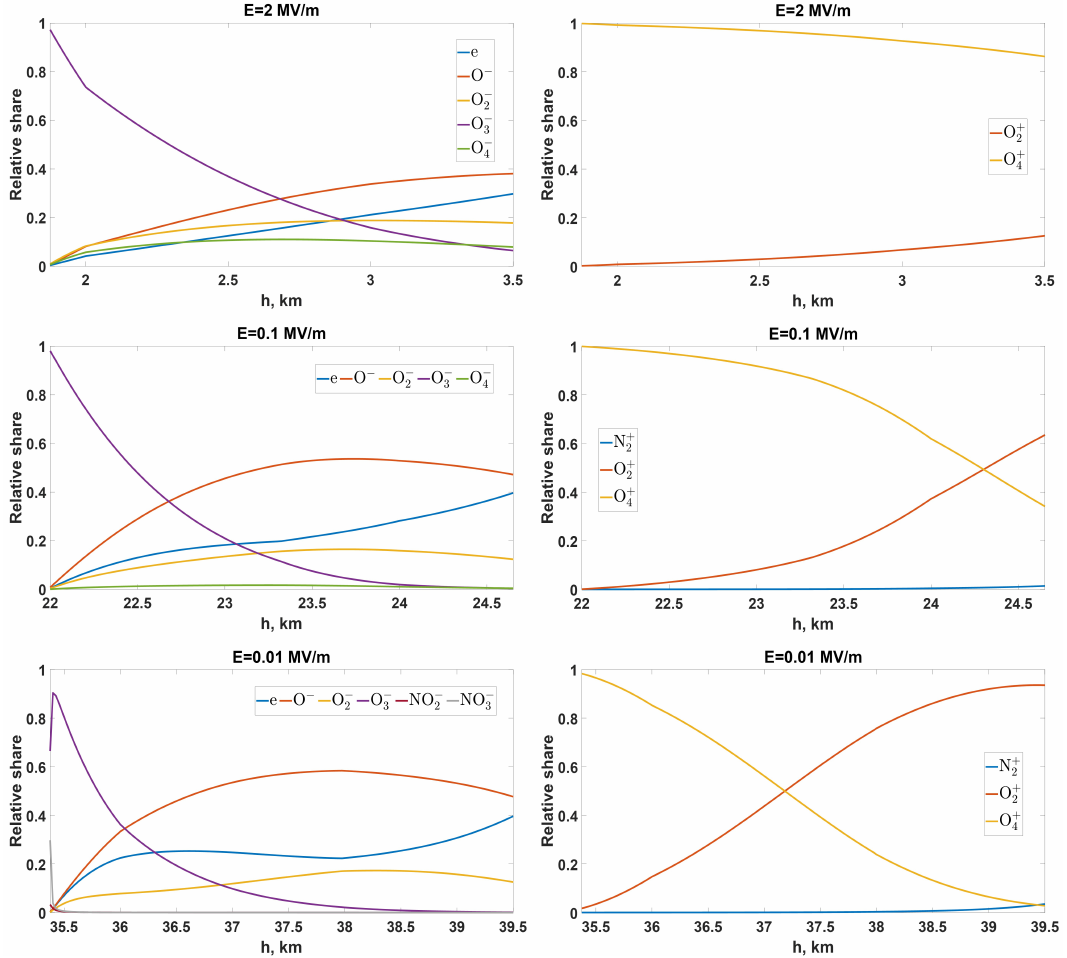
Figure 5. Dependence curves of charged particles composition on altitude AMSL h for several fixed electric fields E . The lower altitude limits correspond to heights at which E = E c . Components with negligible relative fractions are not